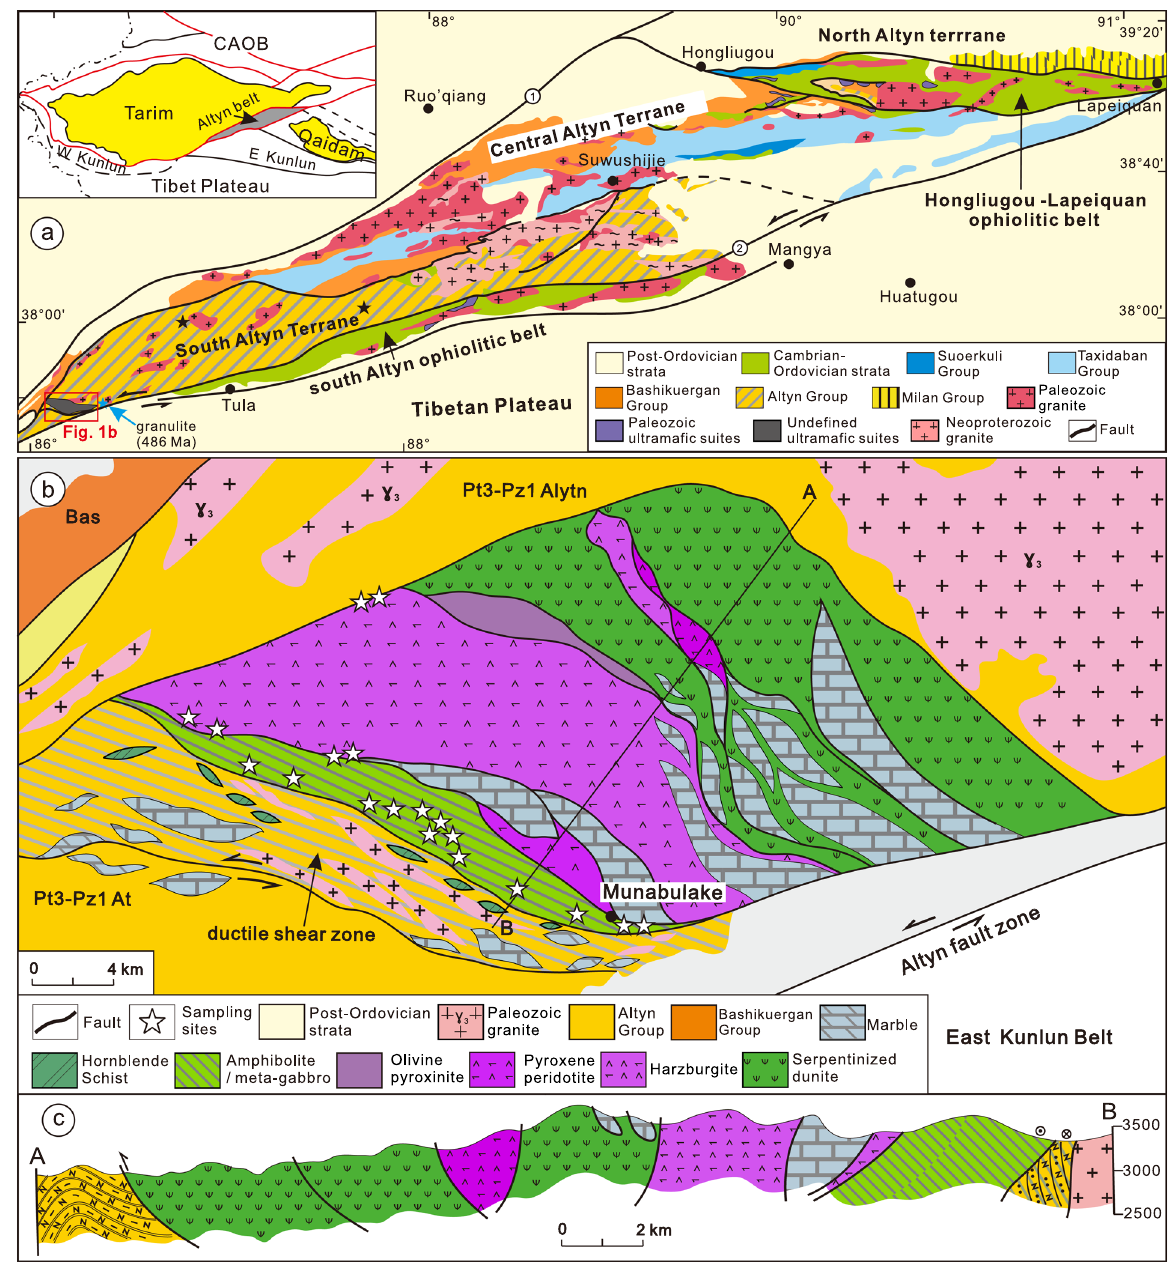
Fig. 2 Geological sketch map and cross section of the Altyn belt and Munabulake area. a Geological sketch map of the Altyn Belt. b Geological map of the Munabulake ophiolite. c Regional cross section of the Munabulake